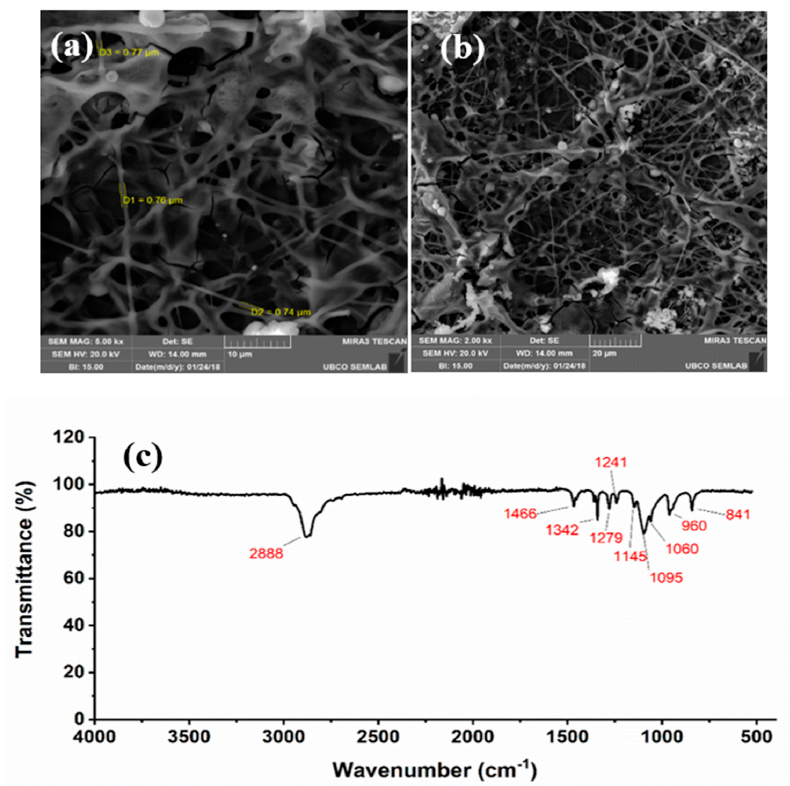
Figure 2. SEM images of the sensing layer after calcination for four hours at ( a ) 300 ◦ C; ( b ) 400 ◦ C; and ( c ) infrared spectra of the composite used as sensing